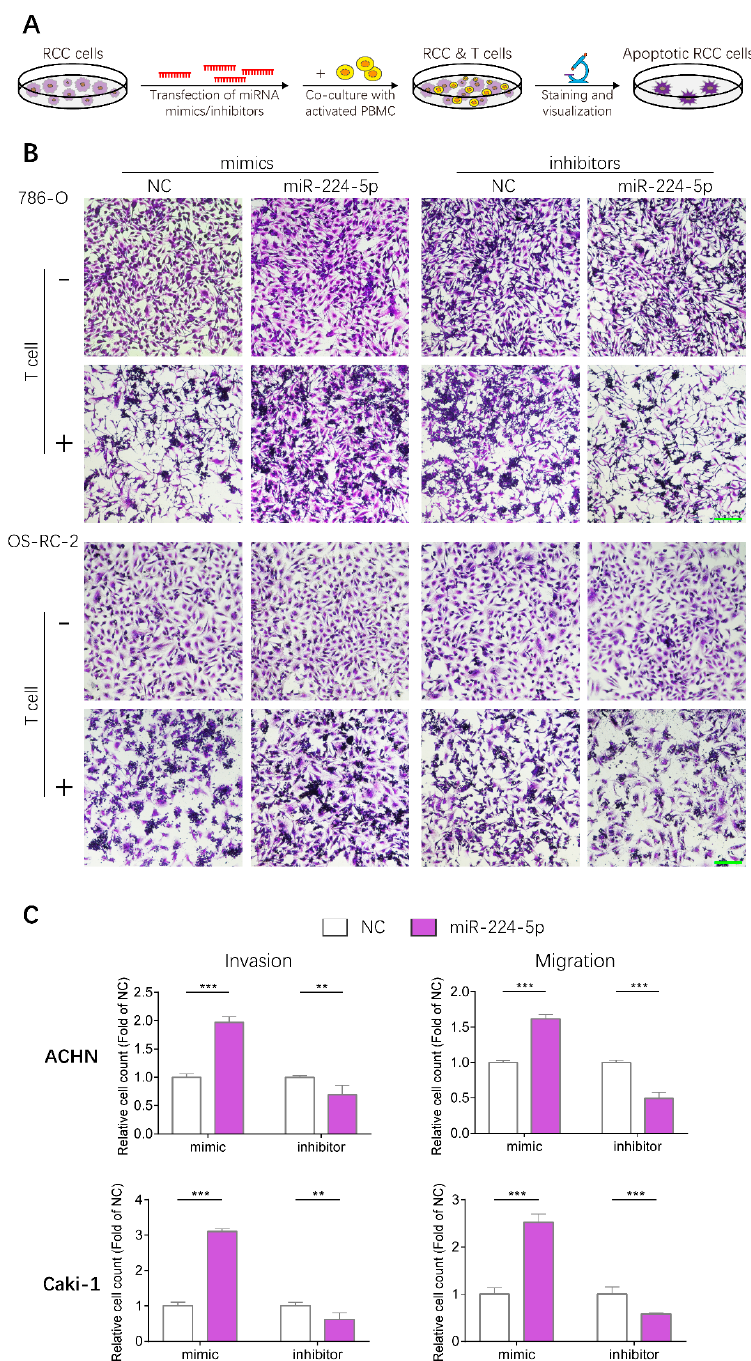
Figure 8. miR-224-5p enhanced resistance to T cell-dependent toxicity, invasive and metastatic abilities of RCC cells. ( A ) Schematic of T cell-dependent RCC cells killing assay. 786-O and OS-RC-2 cells were transfected by miRNA mimcs/inhibitors (100 nM) for 48 h. T cells were isolated from fresh whole blood of healthy volunteers and activated by anti-CD3/CD28/CD2 antibodies for 3 days, and co-cultured with RCC cell for 24 h. Viable RCC cells were stained by crystal violet and visualized by a microscope. ( B ) Representative images of stained viable RCC cells. Scale bar, 200 µ